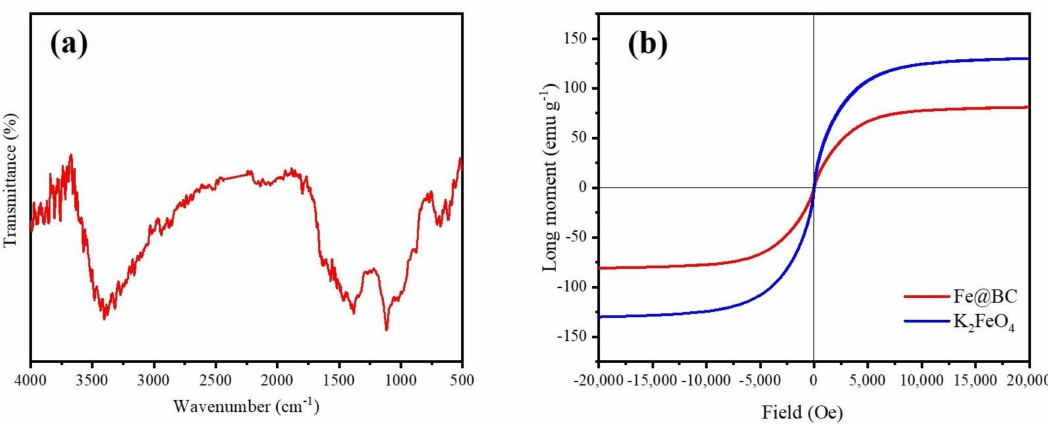
Figure 4. ( a ) Fourier-transform infrared spectrum (FTIR) spectra and ( b ) Magnetic hysteresis loop of Fe@BC and K 2 FeO